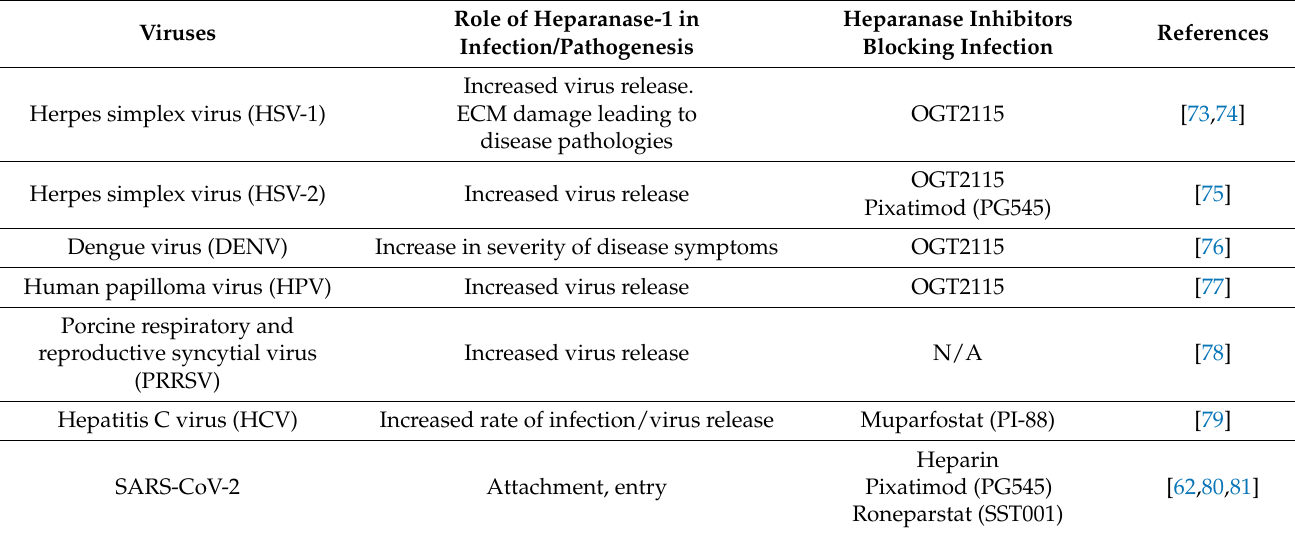
Table 1. Role of heparanase-1 in viral